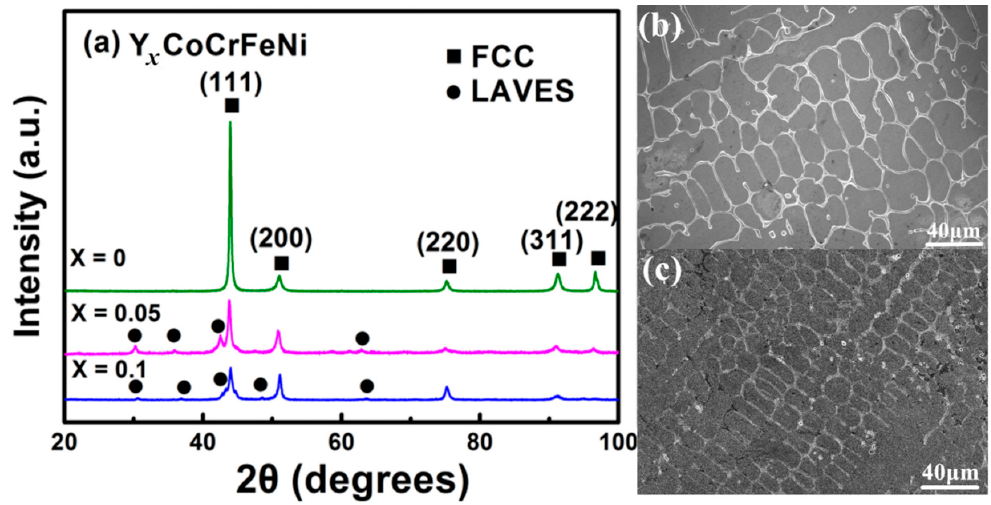
Figure 4. ( a ) XRD patterns of the Y x CoCrFeNi; ( b ) SEM microstructures of Y 0.05 CoCrFeNi; ( c ) SEM microstructures of Y 0.1 CoCrFeNi.